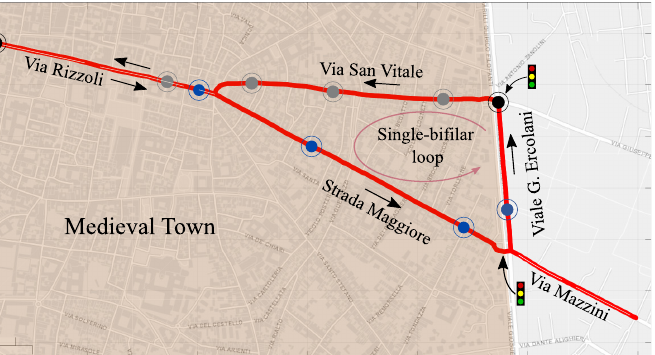
Figure 2. Bus stops of line 14 in FS MTT. Initial and final stops for outward and return journey (black points); intermediate stops for outward journey (blue); intermediate stops for return journey (grey). Arrows indicate the trolleybuses’ travel